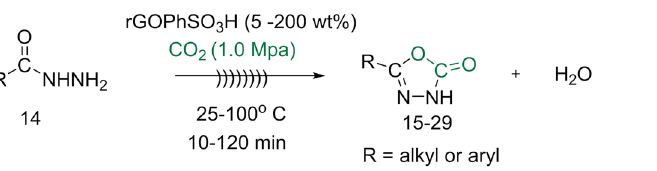
Figure 7. Synthesis of 5-susbstituted-1,3,4-oxadiazole-2-ones.